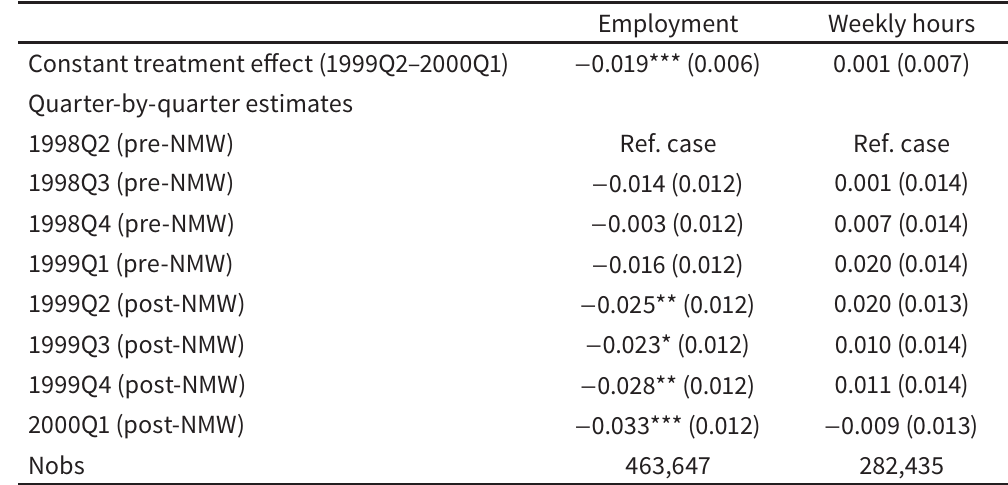
Difference-in-differences estimates of impacts of the NMW introduction on em- ployment and hours in NI, coefficients (robust standard errors) Employment Weekly